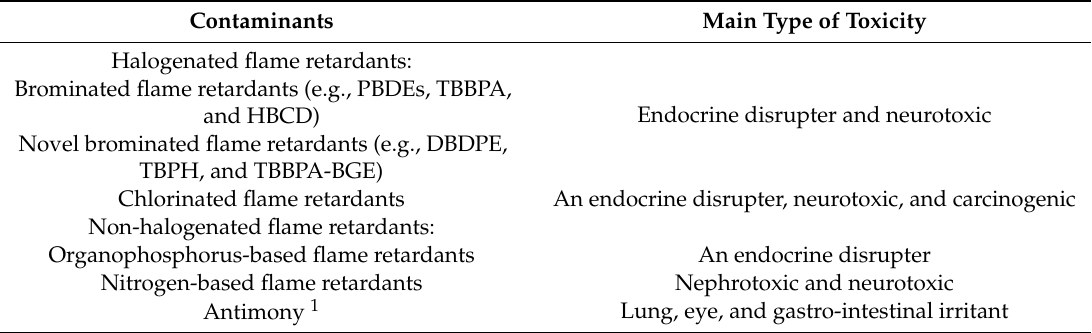
Table 1. Toxicity related to e-plastics containing flame retardants